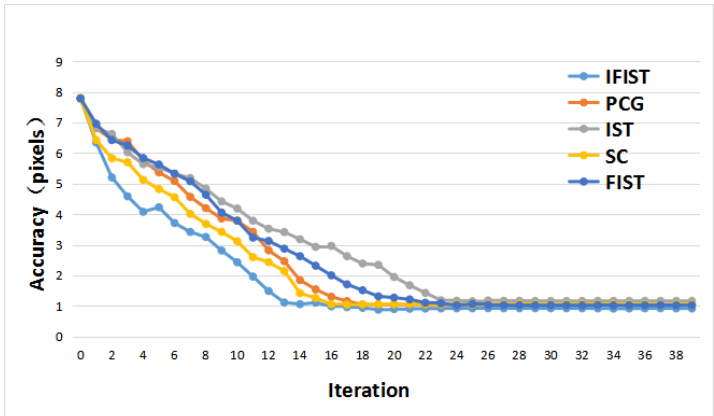
Figure 9. A Comparison of different methods to solve the rank-deficient equation matrix. FIST: fast iterative shrinkage-thresholding; IFIST: improved FIST; IST: iterative shrinkage-thresholding; PCG: preconditioned conjugate gradient; SC: spectrum